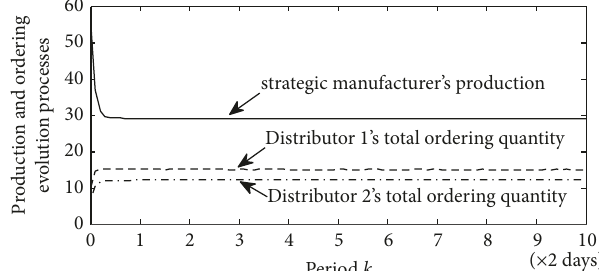
Figure 4: Evolution processes of control variables under the first initial inventory statuses ( ×10 5 ton).